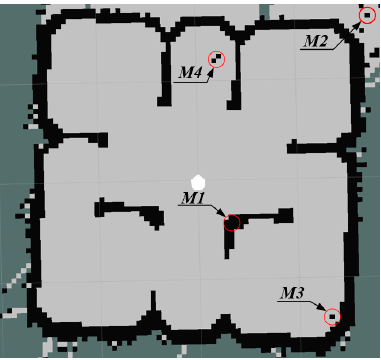
Figure 12. Definition of the four grid types.